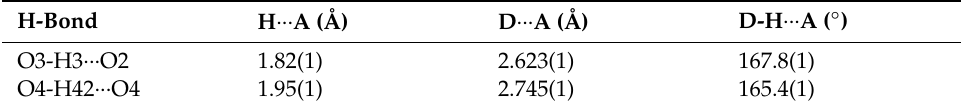
Table 1. Hydrogen-bond geometry of 1 (arbitrary atom-numbering scheme used in Figure